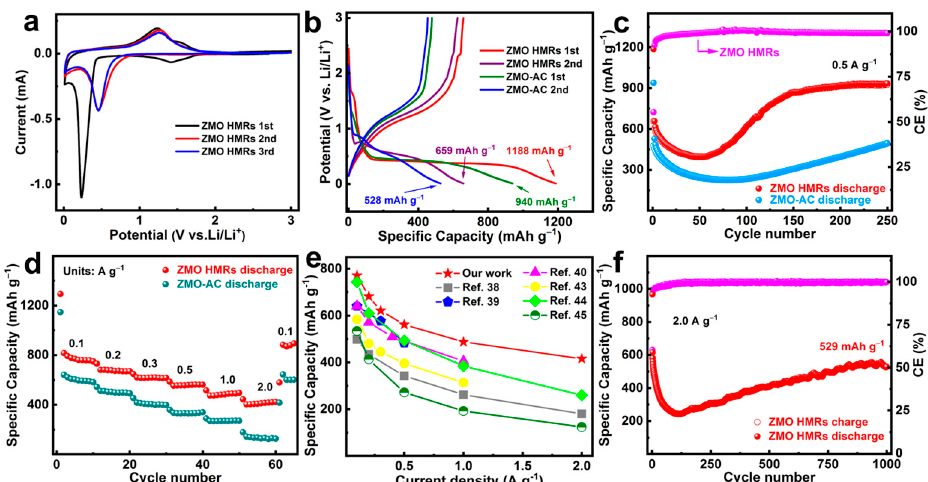
Figure 5. Electrochemical evaluation of the ZMO HMRs and ZMO-AC: ( a ) CVs curves of ZMO HMRs (0.1 mV s − 1 ), ( b ) galvanostatic charge–discharge profiles at 0.5 A g − 1 , ( c ) cycling stabilities 0.5 A g − 1 , ( d ) rate capacities, ( e ) comparisons in rate performance between ZMO HMRs and other reported Mn-based metal oxide anodes, and ( f ) cycling performance at 2.0 A g − 1 .